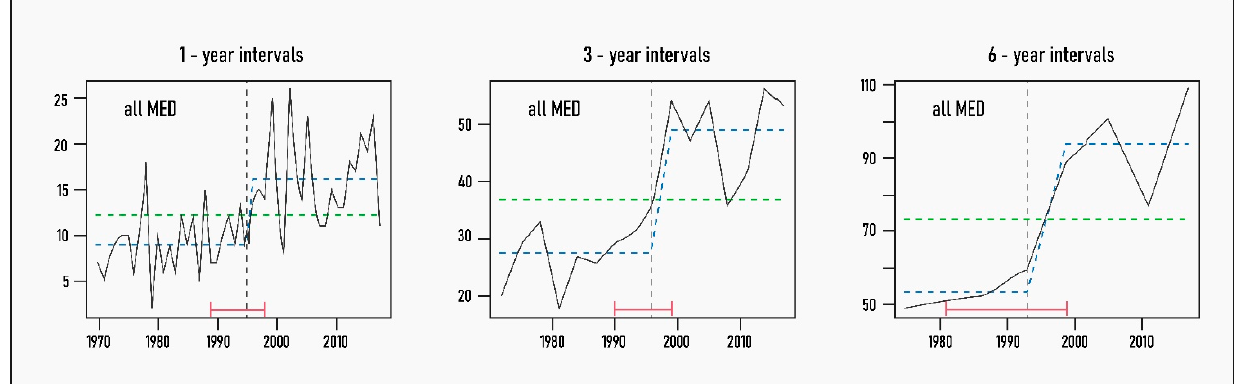
Figure 2. Trends in new NIS introductions for the reduced dataset at the pan-Mediterranean level by 1-, 3- and 6-year increments (continuous black line) with breakpoints and fitted mean values superimposed: vertical dashed line indicates breakpoint or year of significant change in the mean values of new NIS, with 95% confidence intervals in red brackets; dashed green line shows the null model of no temporal change in new NIS numbers; and dashed blue line represents the fitted mean values before and after the identified breakpoint.